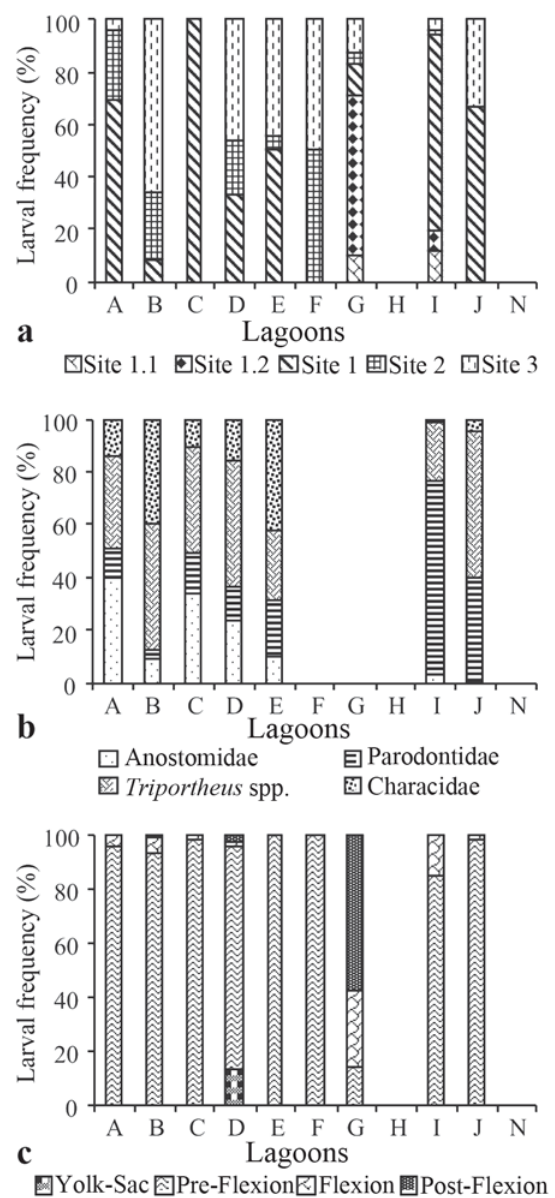
Fig. 3. Spatial distribution of fish larvae in marginal lagoons along the Cuiabá River in December 2006 as a function of: (a) Sampling point (1 = entrance, 2 = middle, 3 = end of lagoon, 1.1 = entrance of channel and 1.2 = end of channel, only in lagoons that present this characteristic); (b) Frequency of occurrence of the four taxa with the highest densities; and (c) Developmental